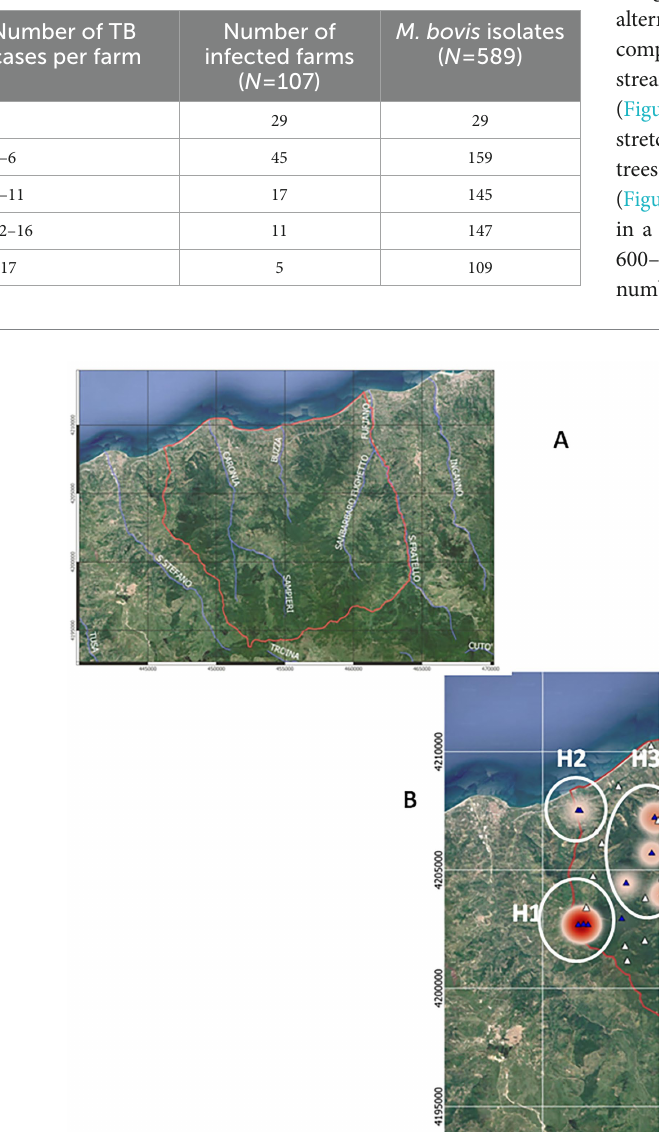
TABLE 1 Number of infected farms and of Mycobacterium bovis isolates by number of cases per farm.